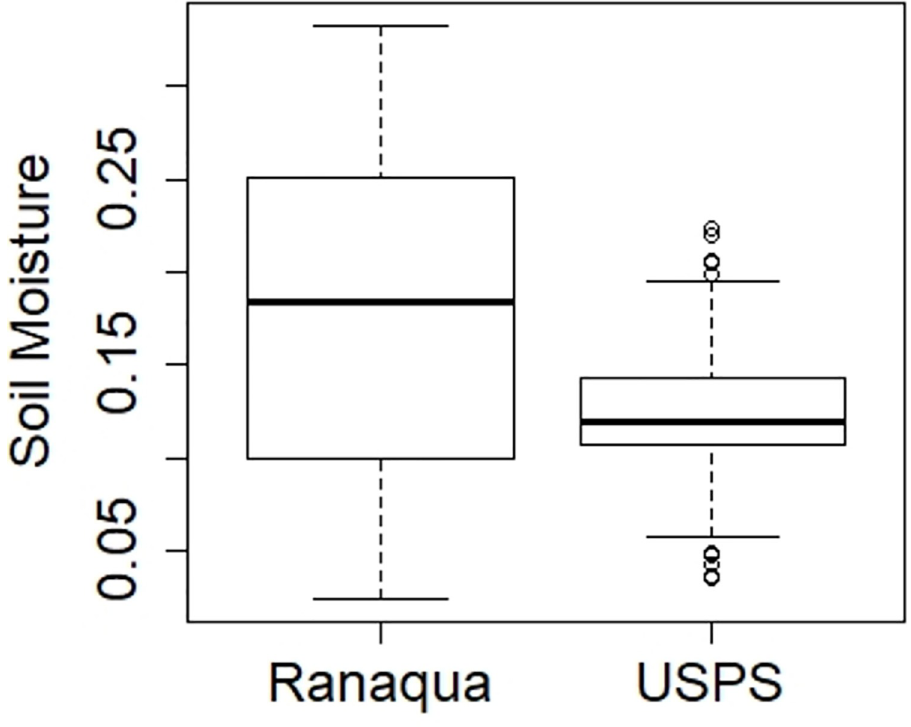
Fig 8. Soil Moisture at the beginning of rainfall